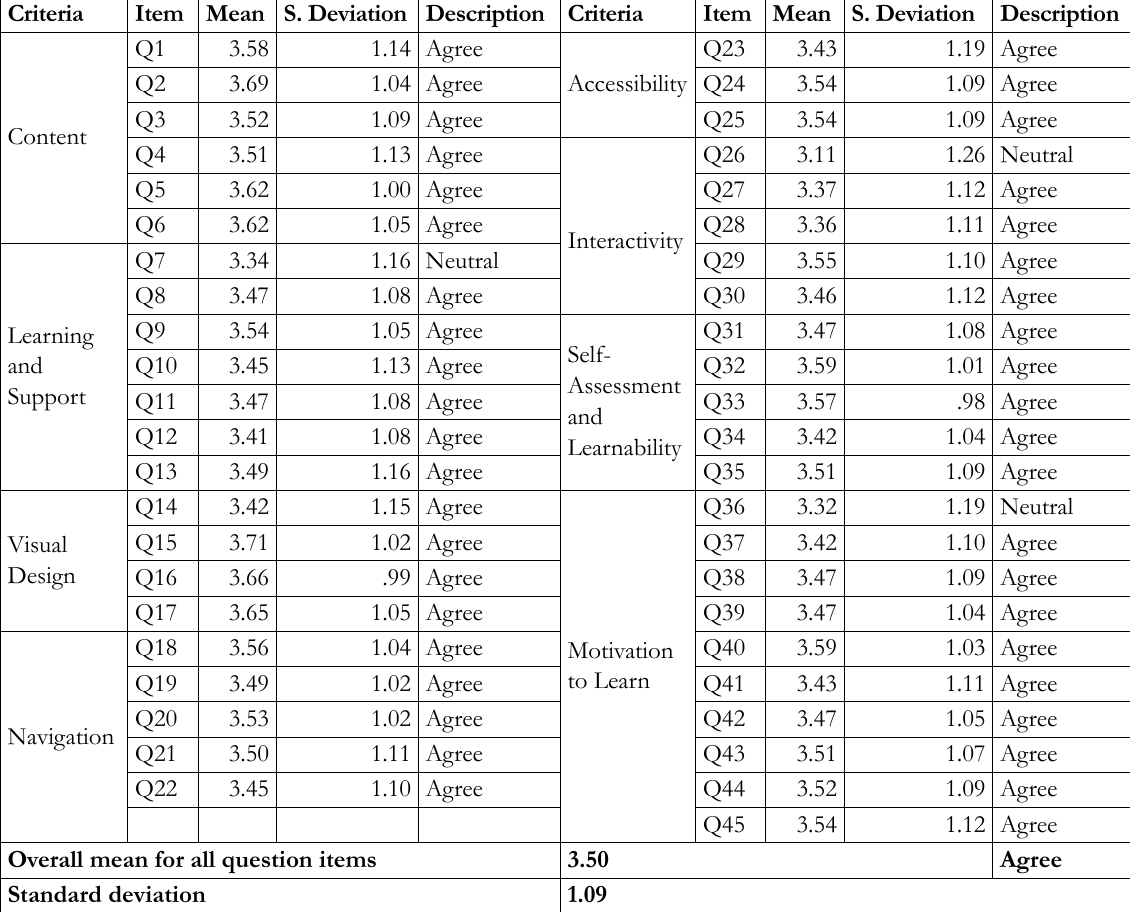
Table 6. Descriptive statistics for the students’ responses to the items about the usability of the e-learning courses at Ajman